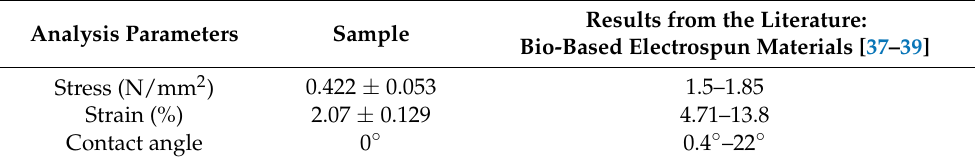
Table 1. Stress–strain with standard deviation and contact angle measurements for final material. Analysis